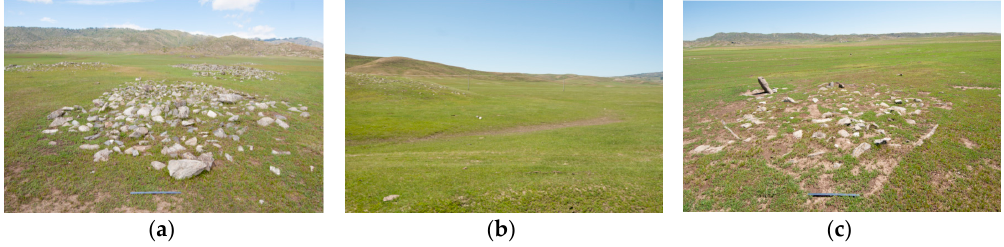
Figure 2. ( a ) Example of a Scythian kurgan lining up with others of its kind; ( b ) Example of a Saka kurgan (left side) with a clearly visible ditch; ( c ) Example of a Turkic ogradka . The scale bar seen in photos ( a ) and ( c ) is 50 cm long.